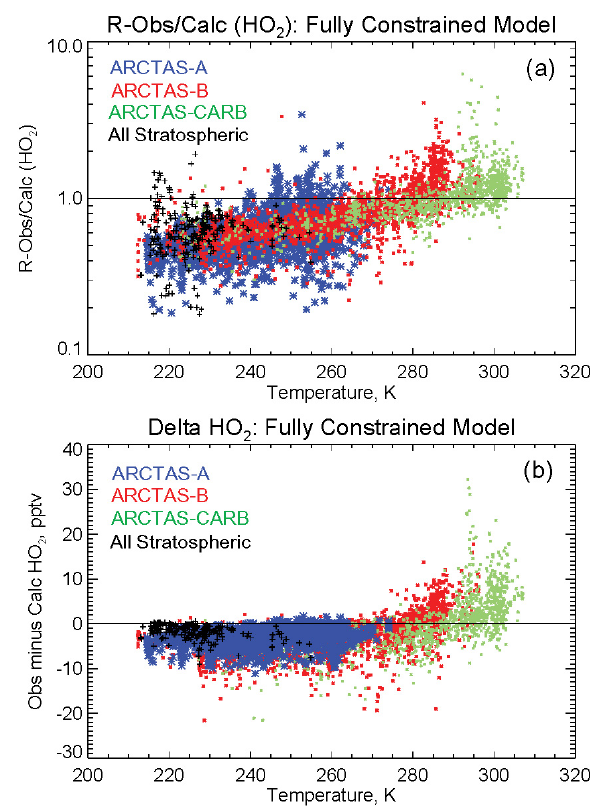
Fig. 15. Model predicted and observation comparisons for HO 2 as a function of temperature. Panel (a) shows R-Obs/Calc (HO 2 ) for ARCTAS-A, -B and -CARB and (b) shows the difference between observations and model predictions for HO 2 as a function of tem-